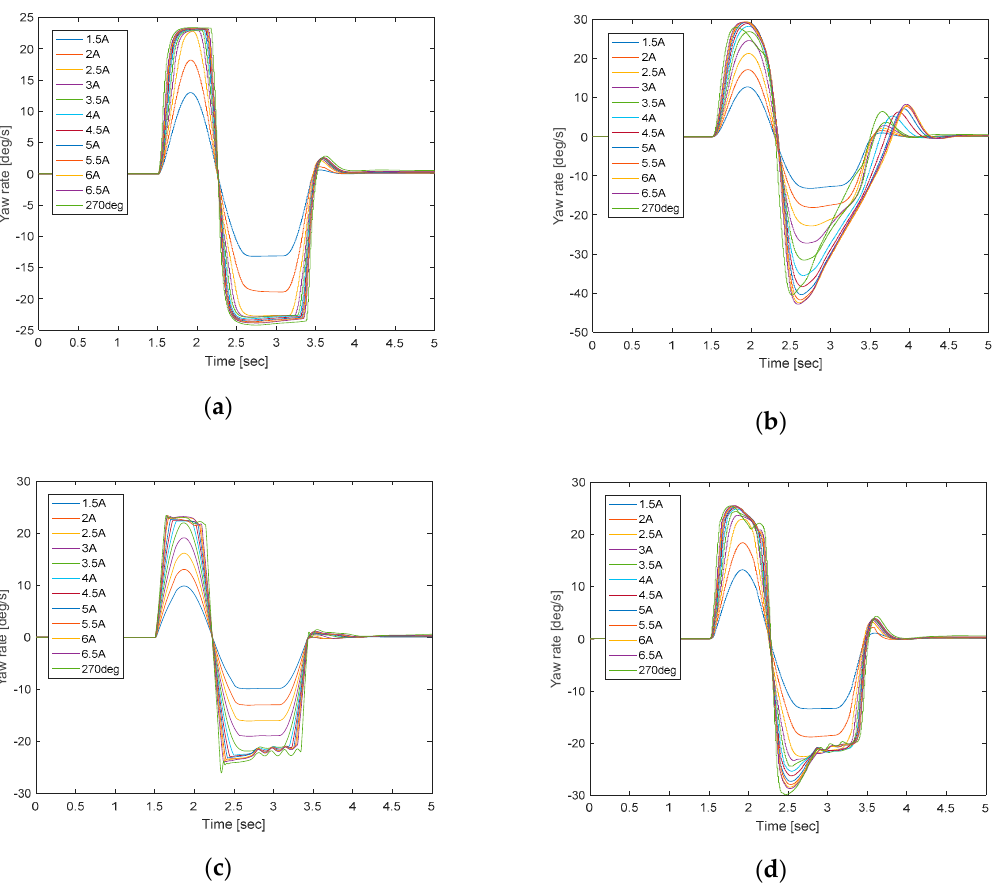
Figure 11. Yaw rate with a friction coefficient of 0.8 in the sine with dwell condition. ( a – d ) show the nominal yaw rate, open-loop control yaw rate, PID control yaw rate and closed-loop control yaw rate plots for the sine with dwell condition on a pavement with an adhesion factor of 0.8.